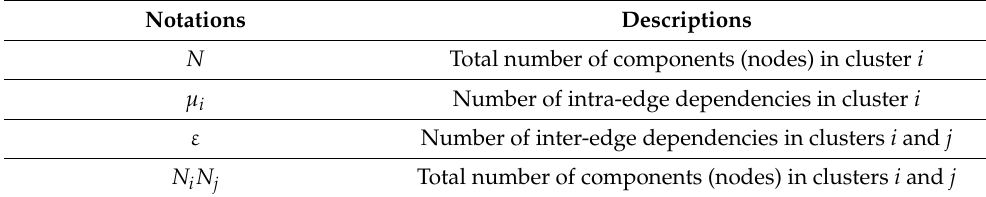
Table 1. Notations for problem